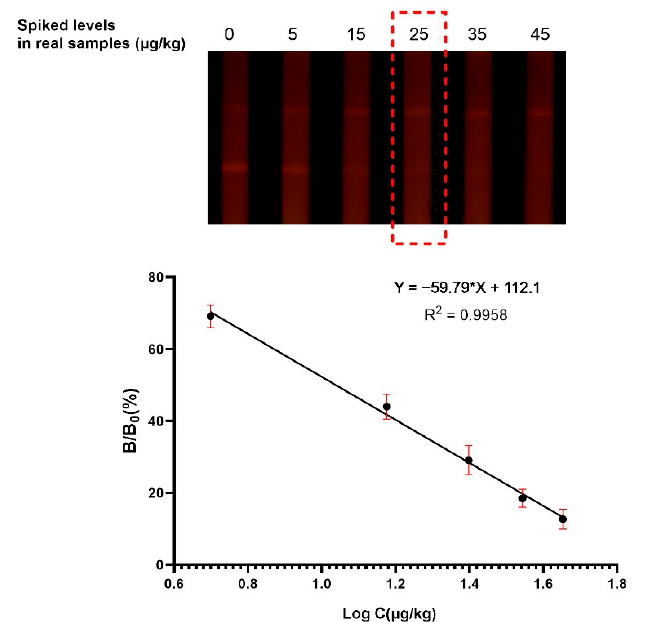
Figure 4. The images and the calibration curve of AFB1 in distillers’ grain samples. The cut-off value was 25 μ g/kg, and the qLOD was 3.4 μ g/kg.